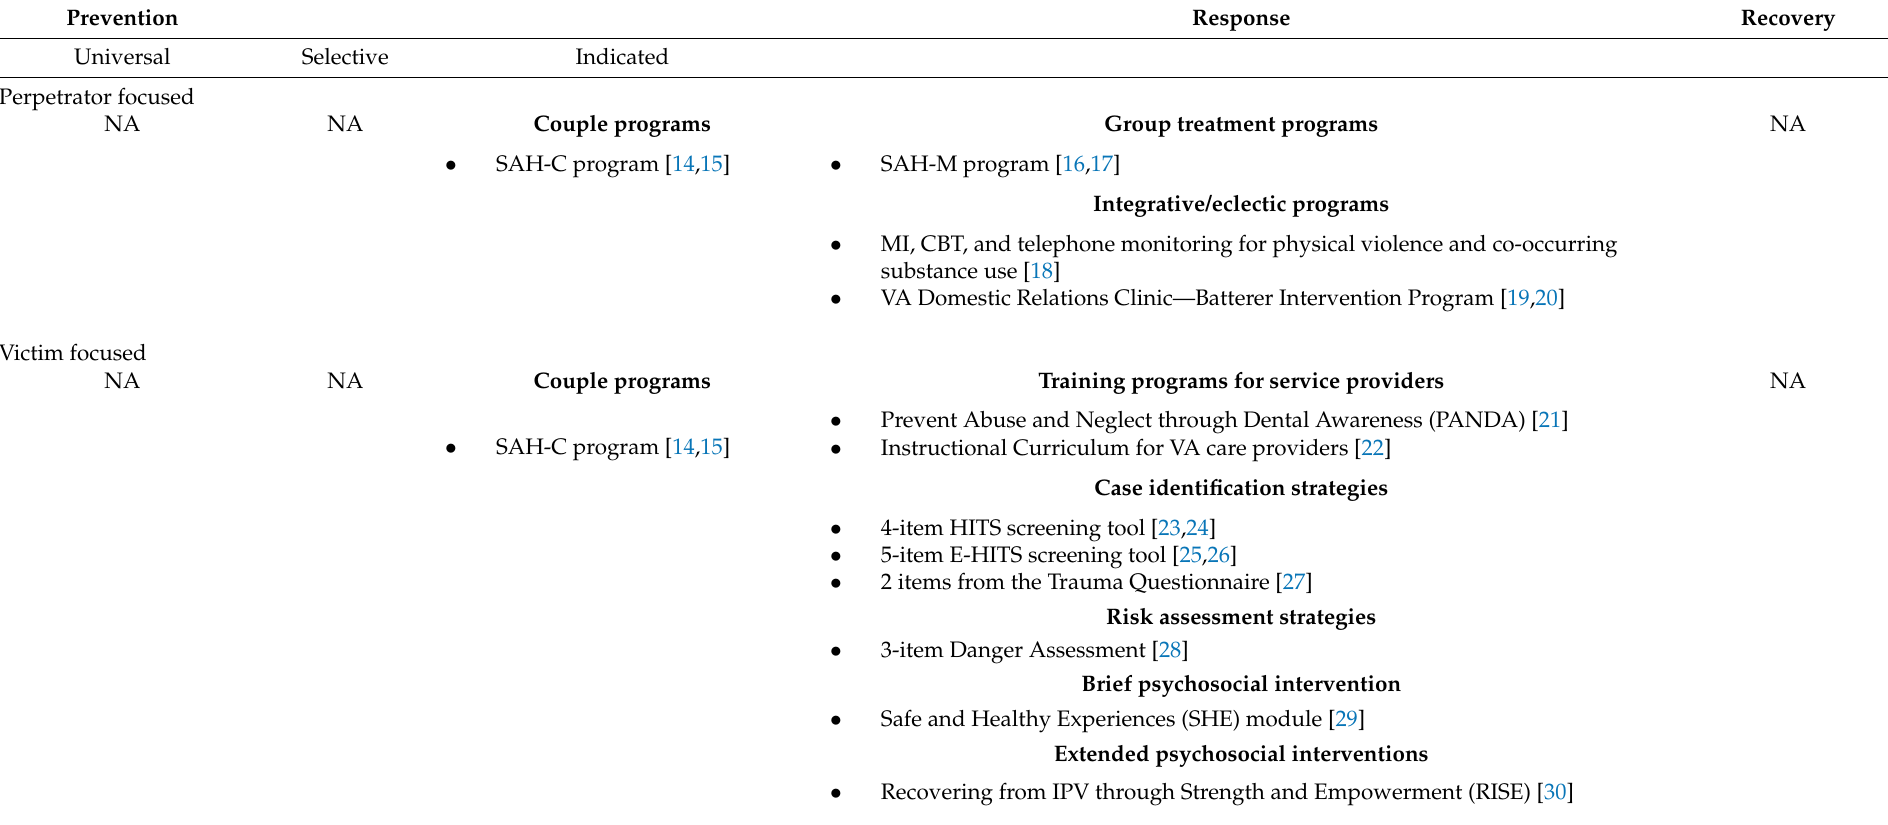
Table 1. Summary of IPV prevention, response and recovery interventions from published